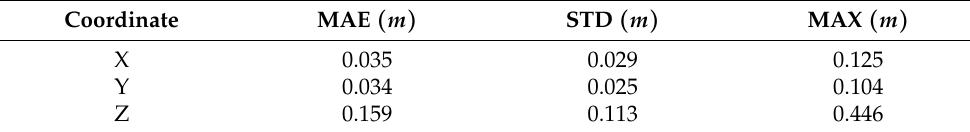
Table 6. Geolocation results.